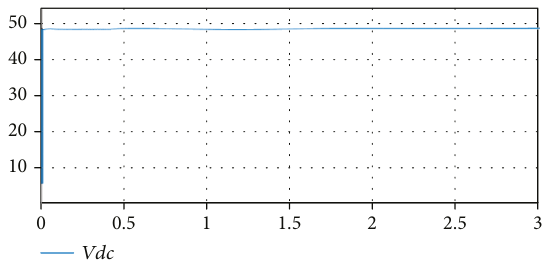
Figure 20: DC-DC boost converter output voltage.